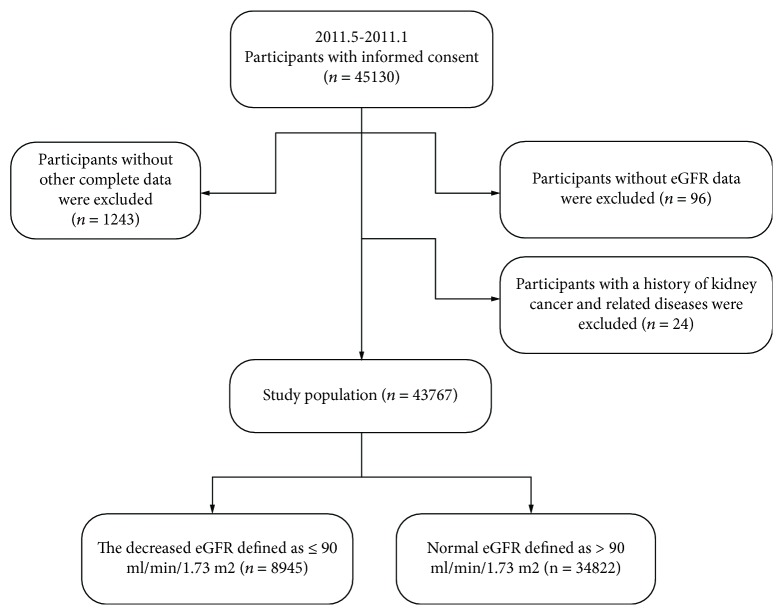
Selection of the study population.